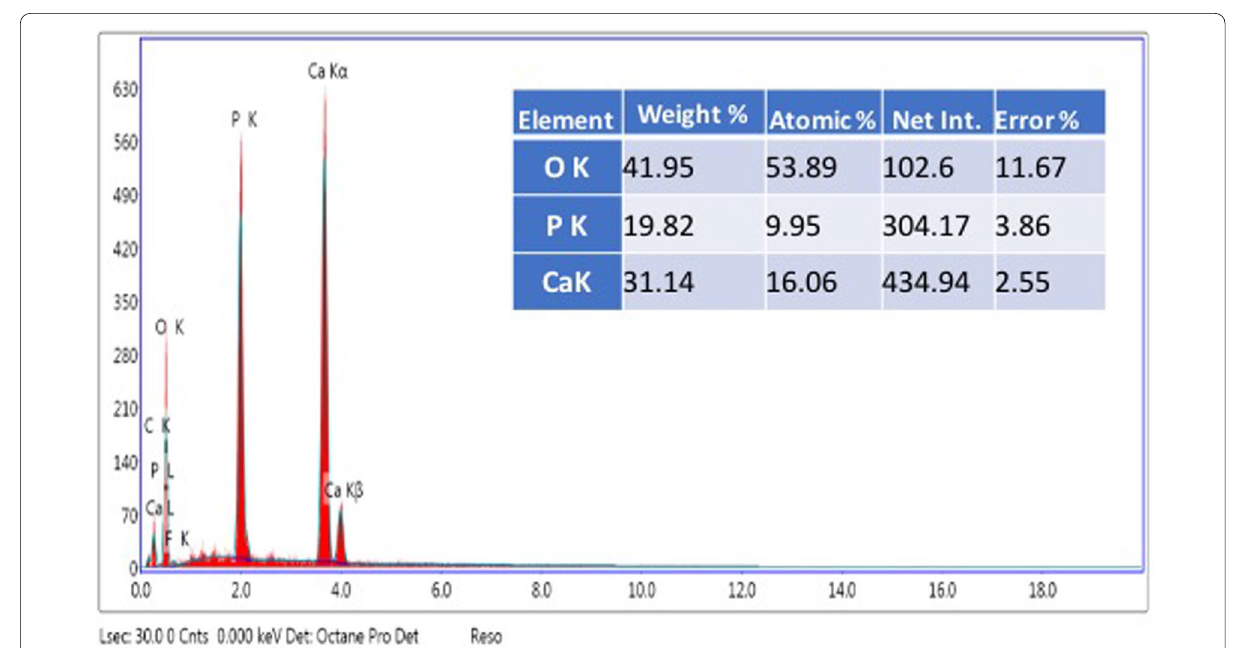
Fig. 3 EDX spectra for the prepared